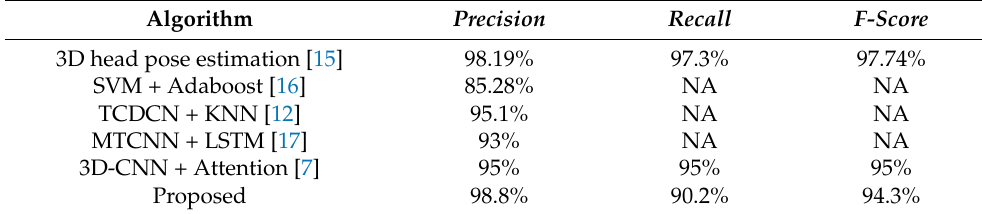
Table 4. A comparison of our results with those in the